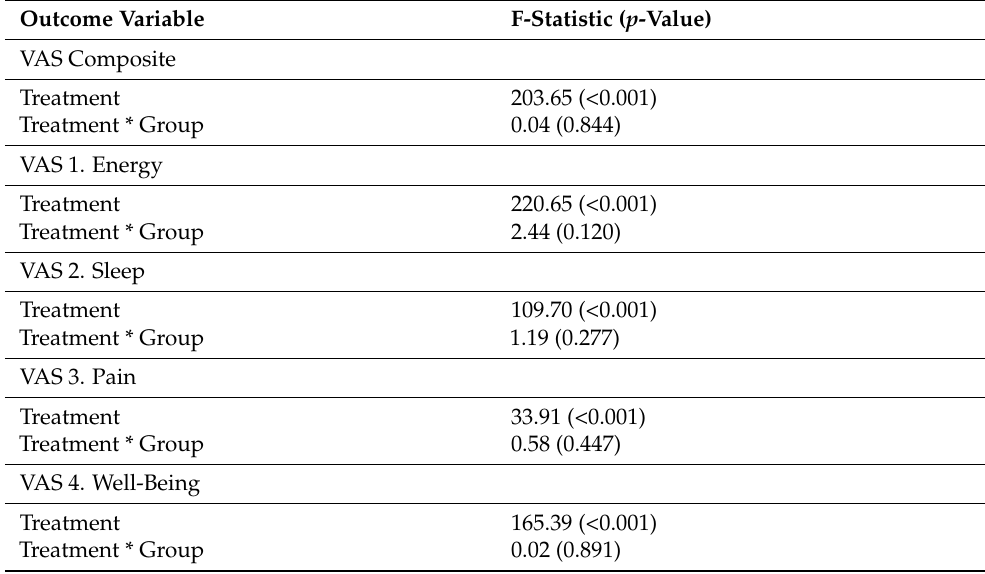
Table 5. Results of Mixed Model ANOVAs Examining Change in Primary and Secondary Outcomes by Supplement Form (N =